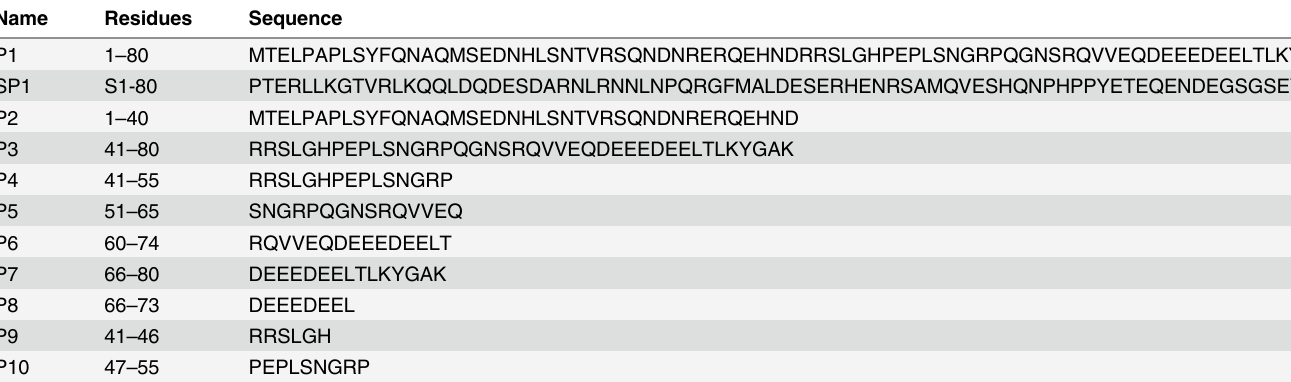
Table 1. Sequences of PS-1 NH 2 -Terminal Domain Used In Peptide